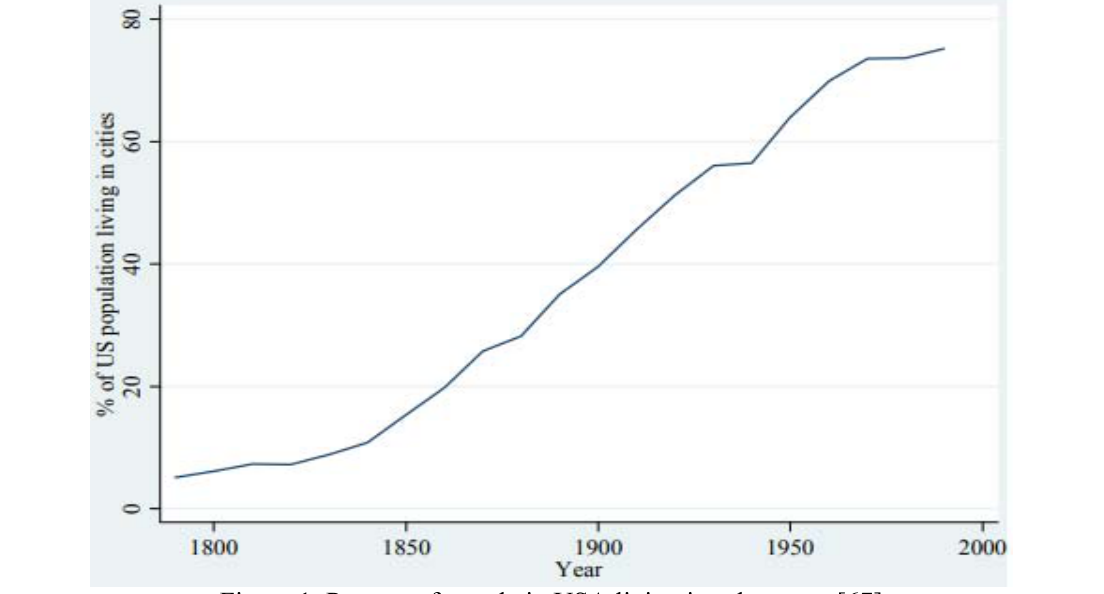
Figure 1. Percent of people in USA living in urban area